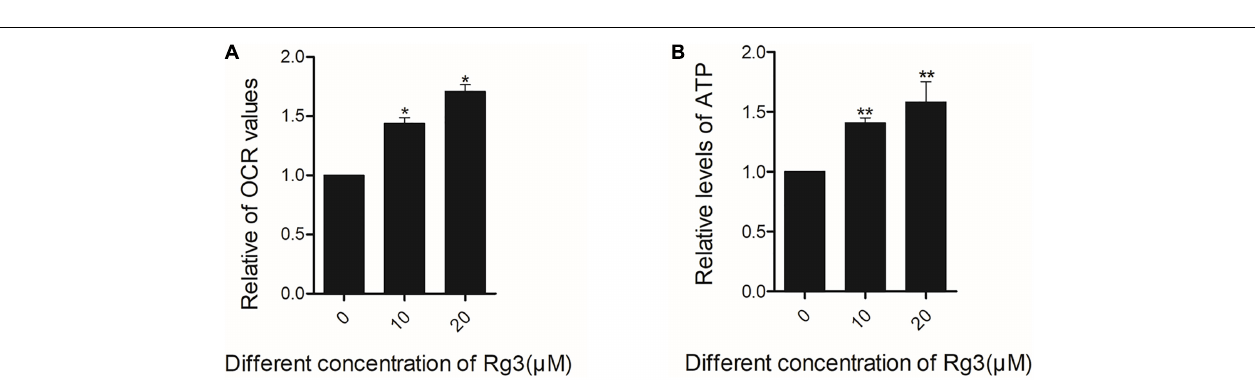
FIGURE 5 | Rg3 promotes mitochondrial biogenesis and function. Cells were treated with different concentrations of Rg3 for 24 h. (A) Cells were stained with 150 nM Mitotracker Green FM for 30 min and imaged with fluorescent microscopy. Scale bar, 100 µ m. (B) Quantitative presentation of the fluorescent intensity on mitochondria shown in panel (A) . Data were collected from three independent experiments and expressed as mean ± SD. ** P < 0.01 (C) Cells were stained with MitoTracker Red CMXRos (100 nM) for 40 min and imaged with fluorescent microscopy. Scale bar, 100 µ m. (D) Quantitative presentation of the fluorescent intensity of mitochondria shown in panel (C) . Data were collected from three independent experiments and expressed in mean ± SD. * P < 0.05.